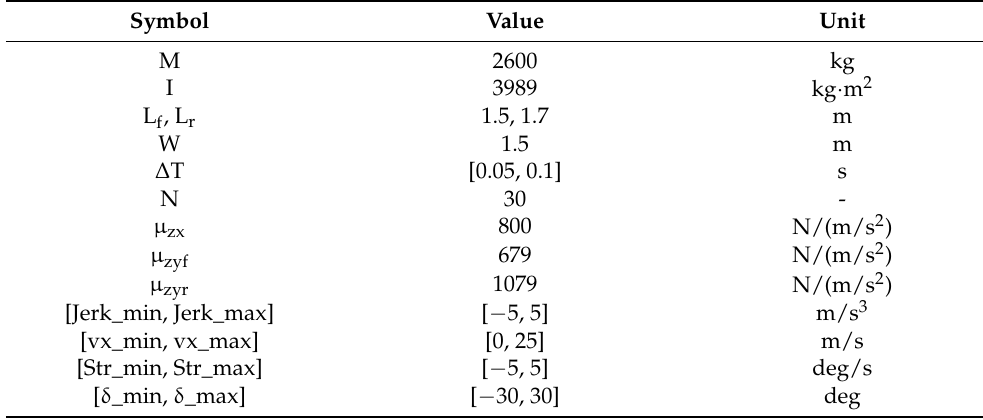
Table 1. Simulation